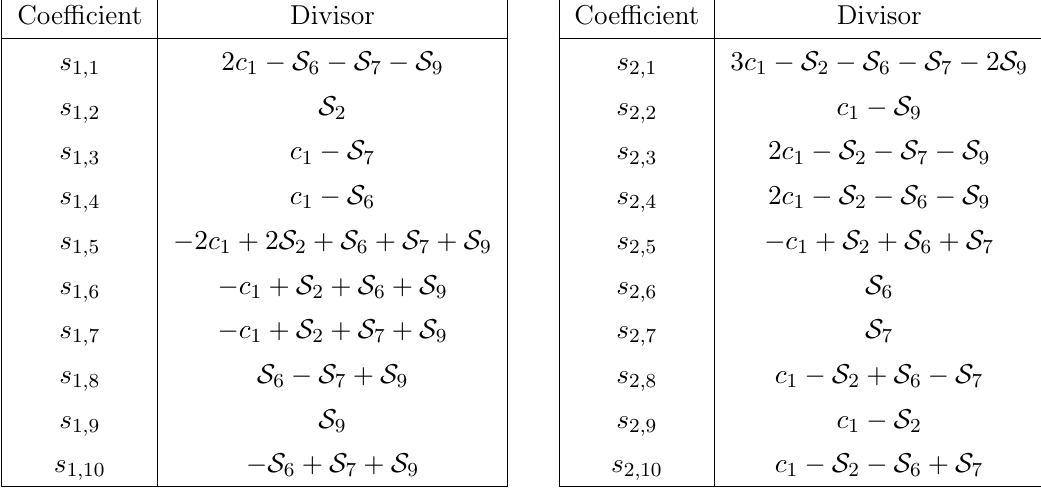
Table 2 . Divisor classes of the coefficients for the biquadric.